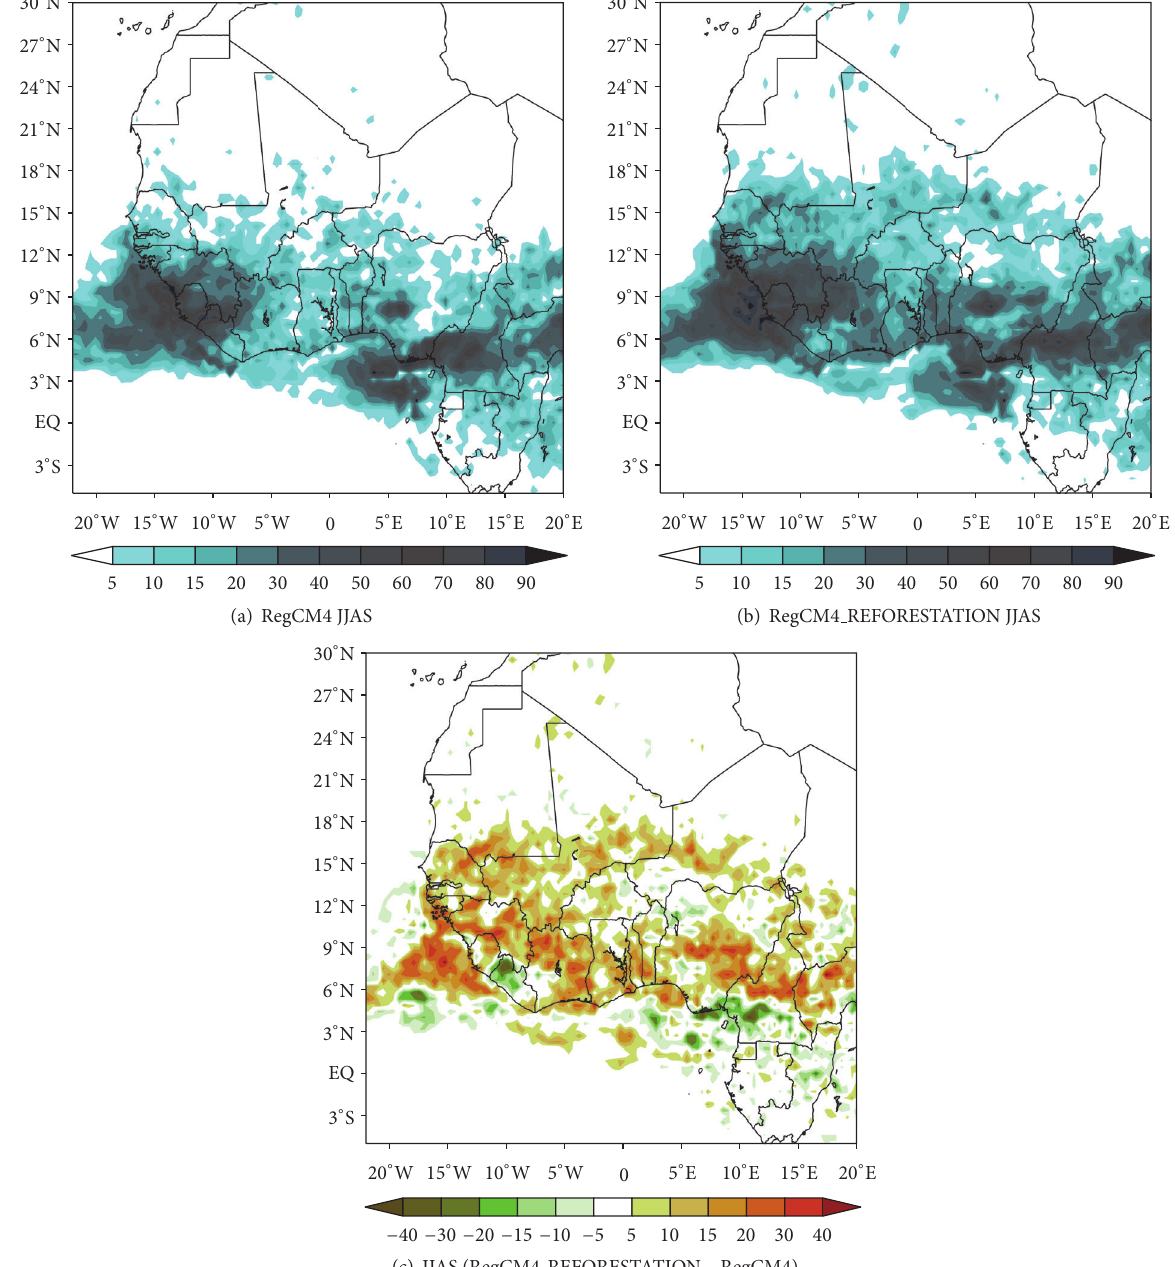
Figure 11: Maximum 5-day precipitation accumulations exceeding 50 mm/day (RX5day) for both runs and their difference averaged from 2003 to